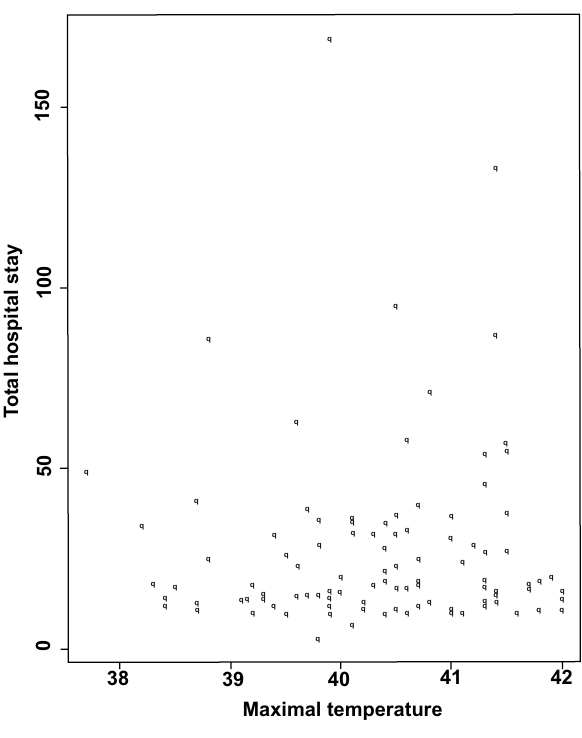
Figure 9. Total hospital stay (days) versus maximal temperature ( ° C). Scatterplot showing the relation between total hospitalization duration and Tmax.